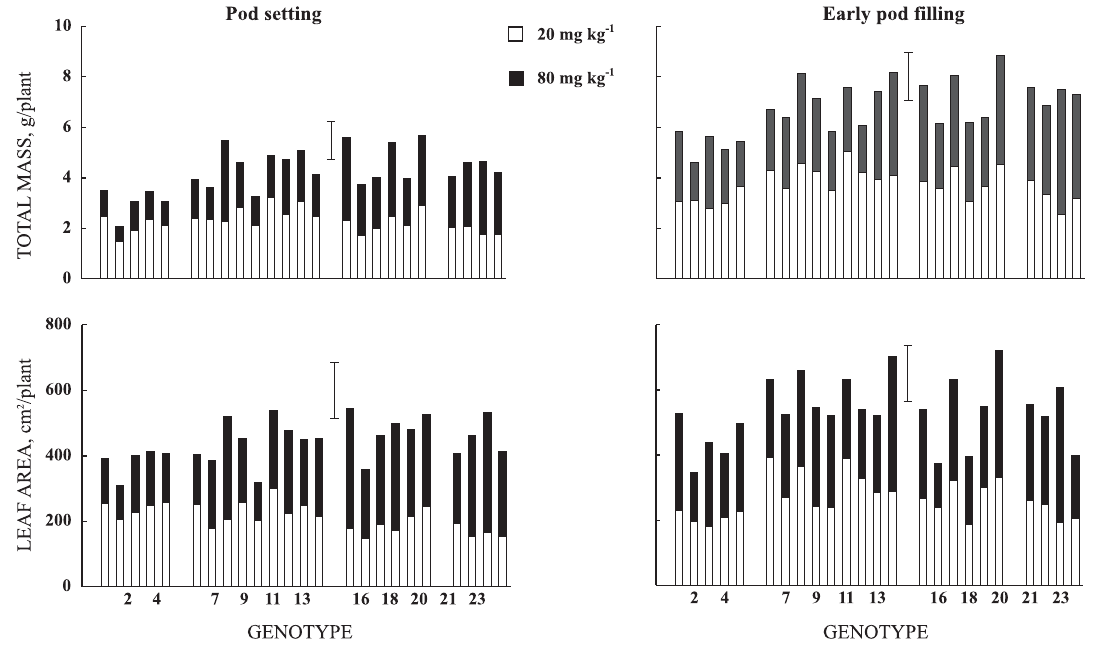
Figure 1. Total dry mass (shoot + root) and leaf area of 24 common bean genotypes grown at P level applied to the soil of 20 ( ) and 80 ( ) mg kg -1 of P at two growth stages (pod setting and early pod filling); means of four replicates. Vertical bars represent the least significant difference by the Tukey test 5 %, and compare genotypes within each P level; names of the genotypes are in Table